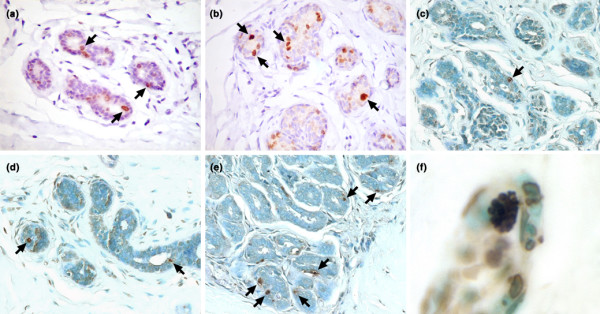
Photomicrographs of human mammary tissue during the follicular and luteal phases of the natural menstrual cycle. (a,b) Ki-67 expression (arrows and/or deep brown color) in epithelial cells from normal mammary lobule of a representative patient in the follicular phase (a) and in the luteal phase (b). (c–f) TdT-mediated dUTP nick end labelling (TUNEL)-positive staining (arrows, deep brown color) indicating apoptotic epithelial cells from representative patients in the follicular phase (c,d) and in the luteal phase (e,f); (f) high magnification of a labeled cell displaying the characteristic features of chromatin condensation and apoptotic bodies.